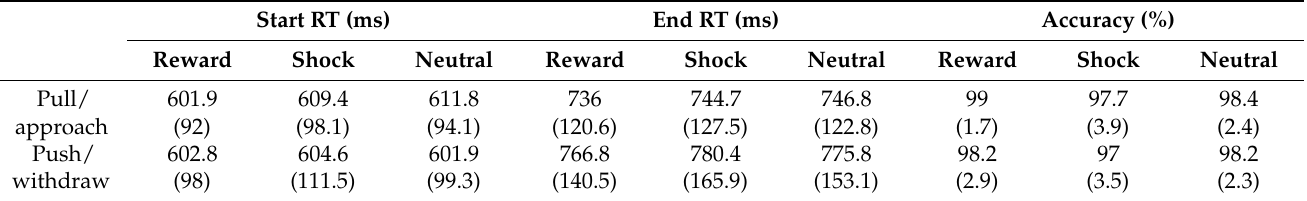
Table 1. Mean start RT, end RT and accuracy as a function of target type and response direction in the training phase of Experiment 1. Numbers in the parentheses represent the standard